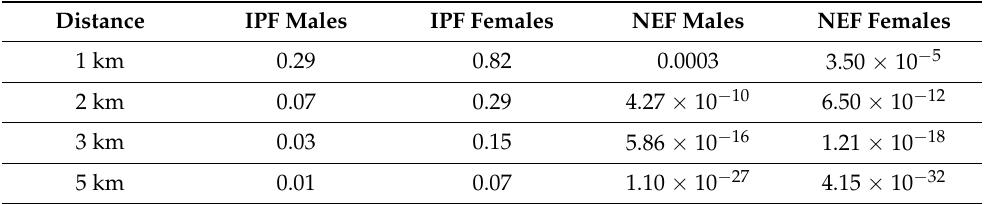
Table 2. Stability index (R 2 ) of the inverse power function (IPF) and the negative exponential function (NEF) based on calculations with 20, 30 and 50 m intervals of the covered distances of Erebia pronoe .